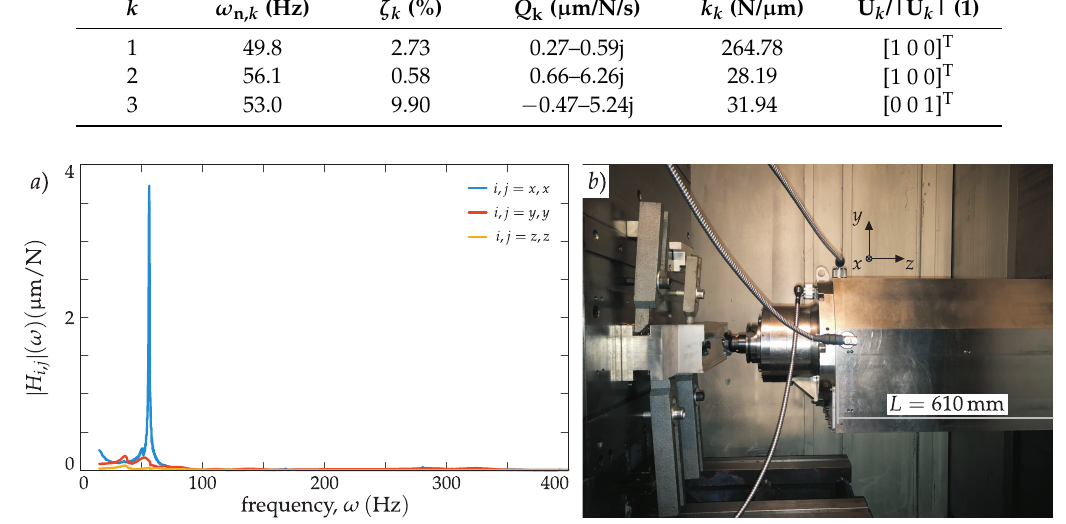
Figure 8. ( a ) shows the direct FRFs with L = 610 mm ram overhang presented in ( b